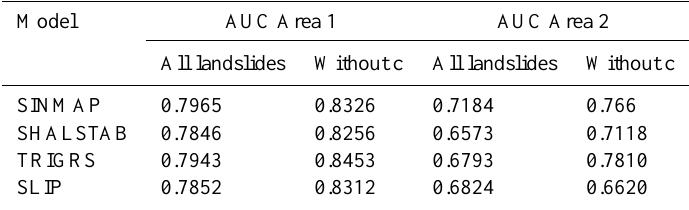
Table 5. Global accuracy of the models (area under the ROC curve).